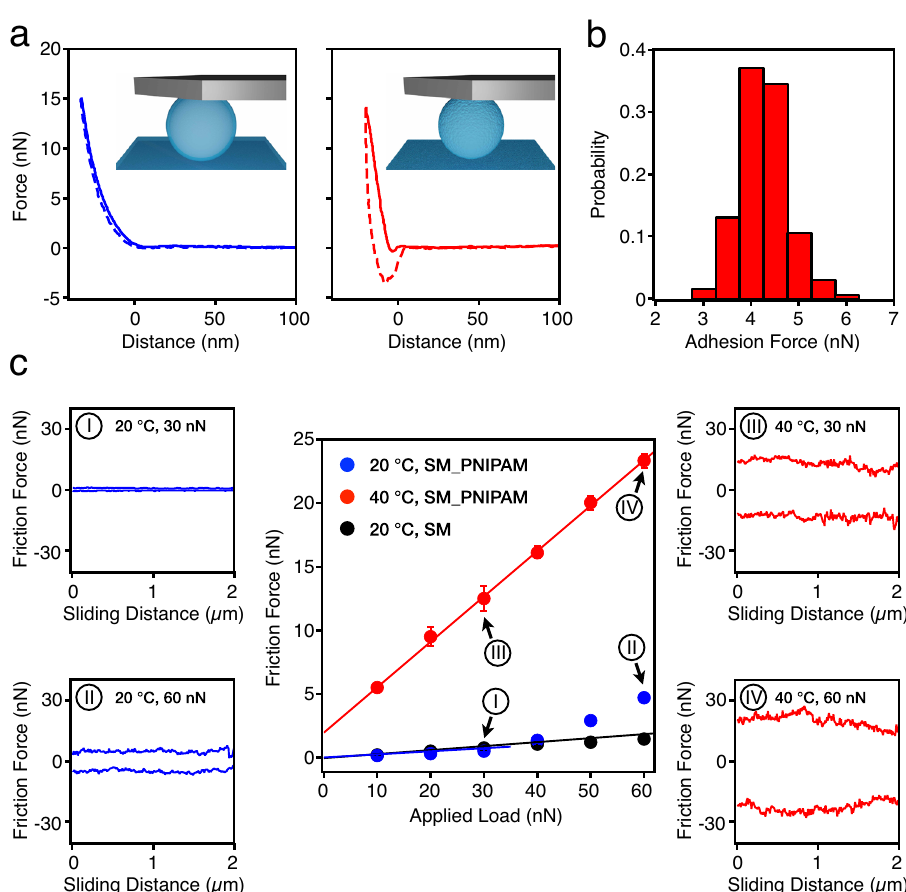
Fig. 2 Nanotribology experiments on PNIPAM-grafted smooth particles. a Approach (solid line) and retraction (dashed line) of the force – distance curves of SM_PNIPAM system at 20 °C (left) and 40 °C (right). The zero-point is determined as the point at which the approach curve shows non-zero vertical de fl ection due to interaction with the substrate. The top two insets show the schematics of a SM_PNIPAM probe on a countersurface at 20 °C (left) and 40 °C (right). b The adhesion forces measured at 40 °C. The bin width is 0.5 nN. c Friction force versus applied load measurements of SM_PNIPAM at 20 °C (blue) and 40 °C (red) and SM (black). Error bars represent the standard deviations across the scan area (51 data points). Friction loops of the SM_PNIPAM system at 30 nN applied load and 20 °C (I); at 60 nN and 20 °C (II); at 30 nN and 40 °C (III); at 60 nN and 40 °C (IV).